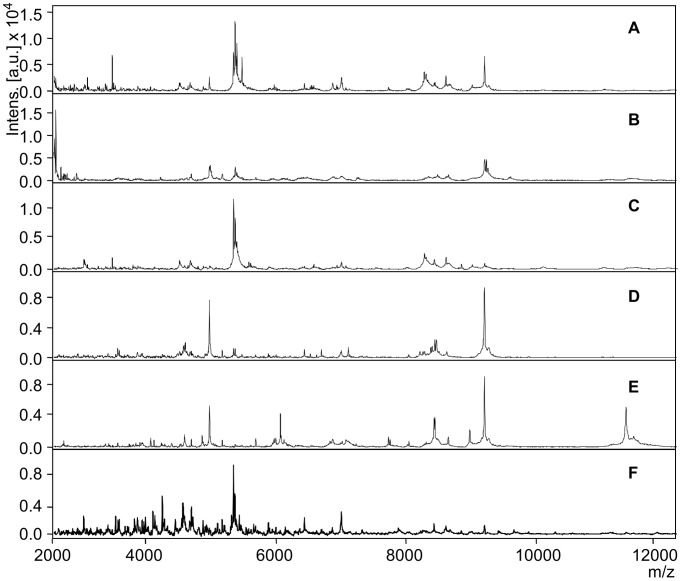
Representative spectra from the whole insect and different body parts of female Glossina austeni.Peak pattern of whole and body parts extractions of Glossina austeni female. The x-axis m/z values represent the mass to charge ratio and on the y-axis the relative intensity of the ions (a.u., arbitrary units) is shown. A) Whole insect, B) abdomen, C) head, D) legs, E) thorax and F) wings.